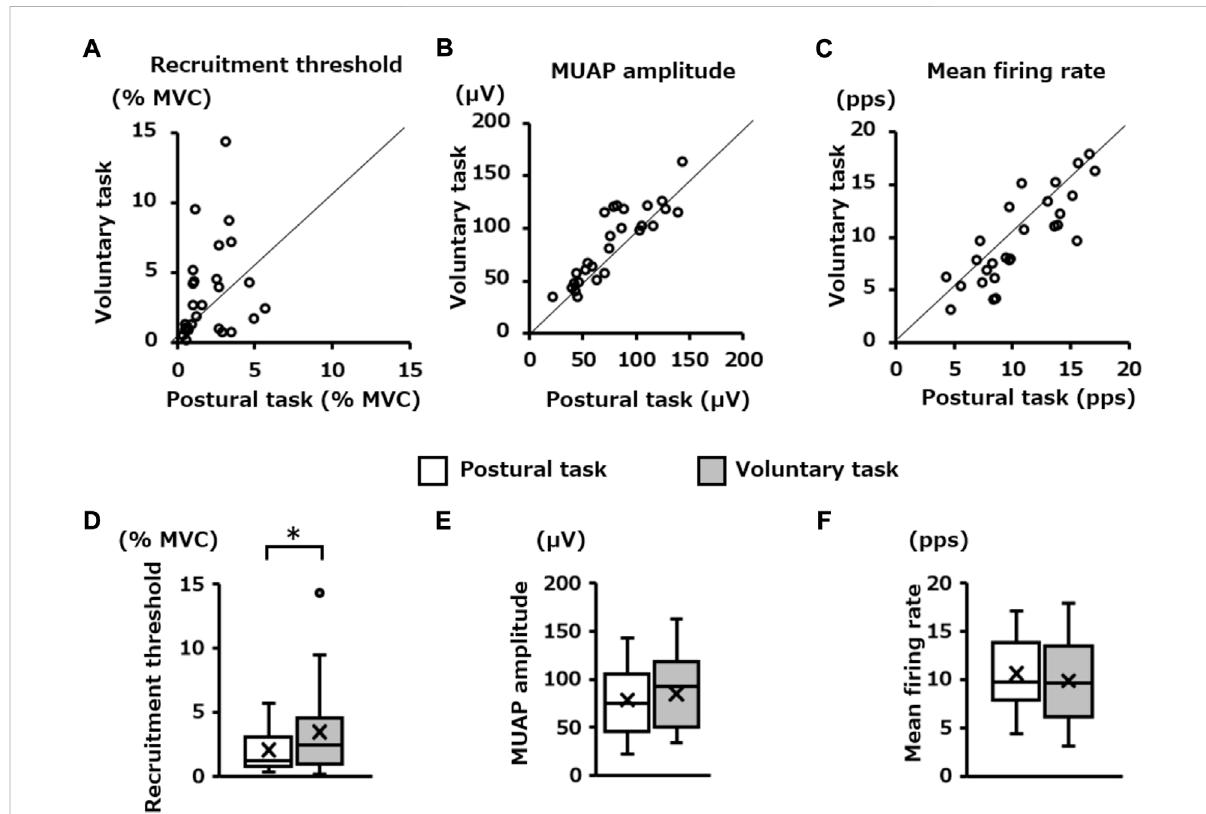
FIGURE 6 Difference in the fi ring properties of the same motor units between the two motor tasks. The scatter plots in the upper panel show the relationship in; (A) recruitment threshold, (B) motor unit action potential (MUAP) amplitude, and (C) mean fi ring rate of the pooled motor units that were determined to be identical between the postural and voluntary tasks. The box plots in the lower panel (D,E,F) show their statistical results (Wilcoxon Signed-rank Test) for each of them. * p <